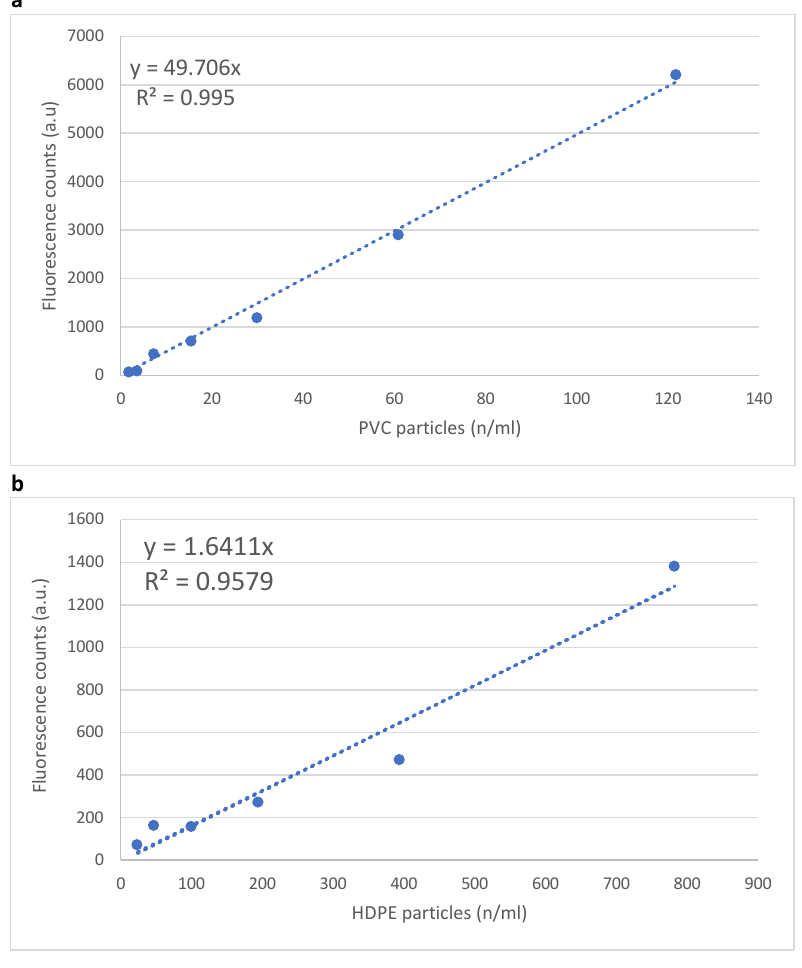
Figure 4. Fluorescence counts recorded versus the number density of added particles of (panel a ) PVC and (panel b ) HDPE test samples.